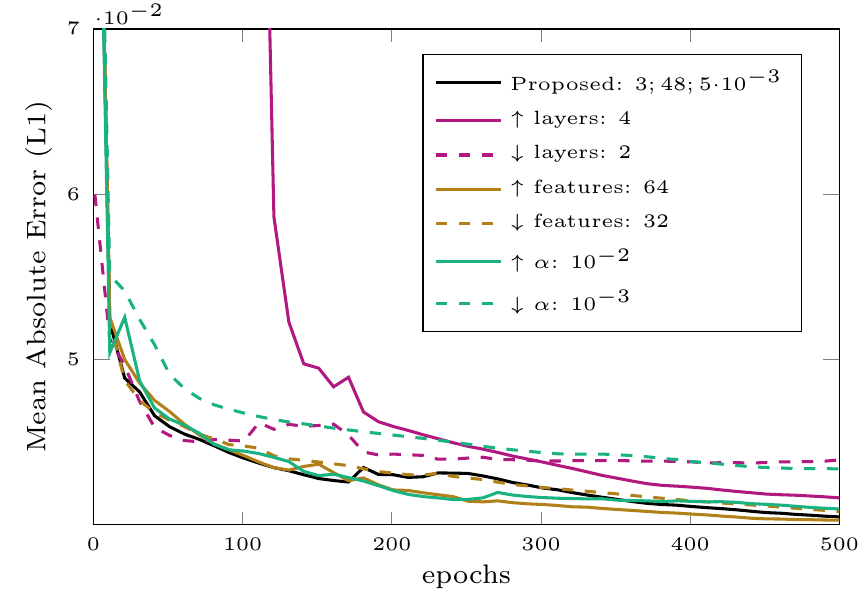
Figure 4. Loss functions for the validation dataset of 3 August. The proposed Optical-SAR model (with 3 layers, 48 features in the 1st layer, and α = 5 10 − 3 ) is compared to several variants obtained by × changing one hyper-parameter at